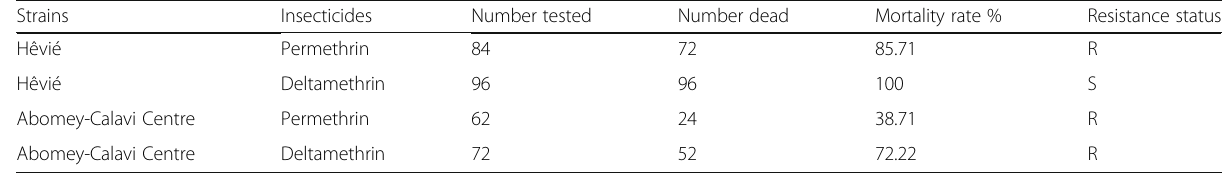
Table 3 Mortality rate of Aedes aegypti to permethrin (0.75%) and deltamethrin (0.05%) in Abomey-Calavi Centre and Hêvié Strains Insecticides Number tested Number dead Mortality rate % Resistance